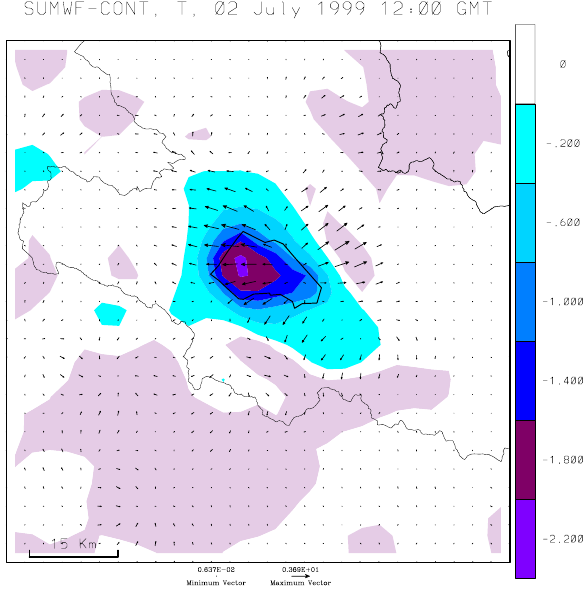
Fig. 4. Near surface temperature (color shading) and wind (arrows) difference between the SUMWF lake and corresponding no-lake cases at 02 July 1999, 12:00GMT. Units are K for temperature and m/s for wind